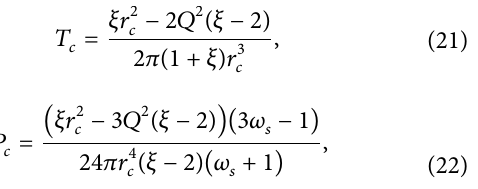
Figure 1: The 𝐹(𝑟 and 푁 = 0.1113 for different values of 𝜉 𝑠